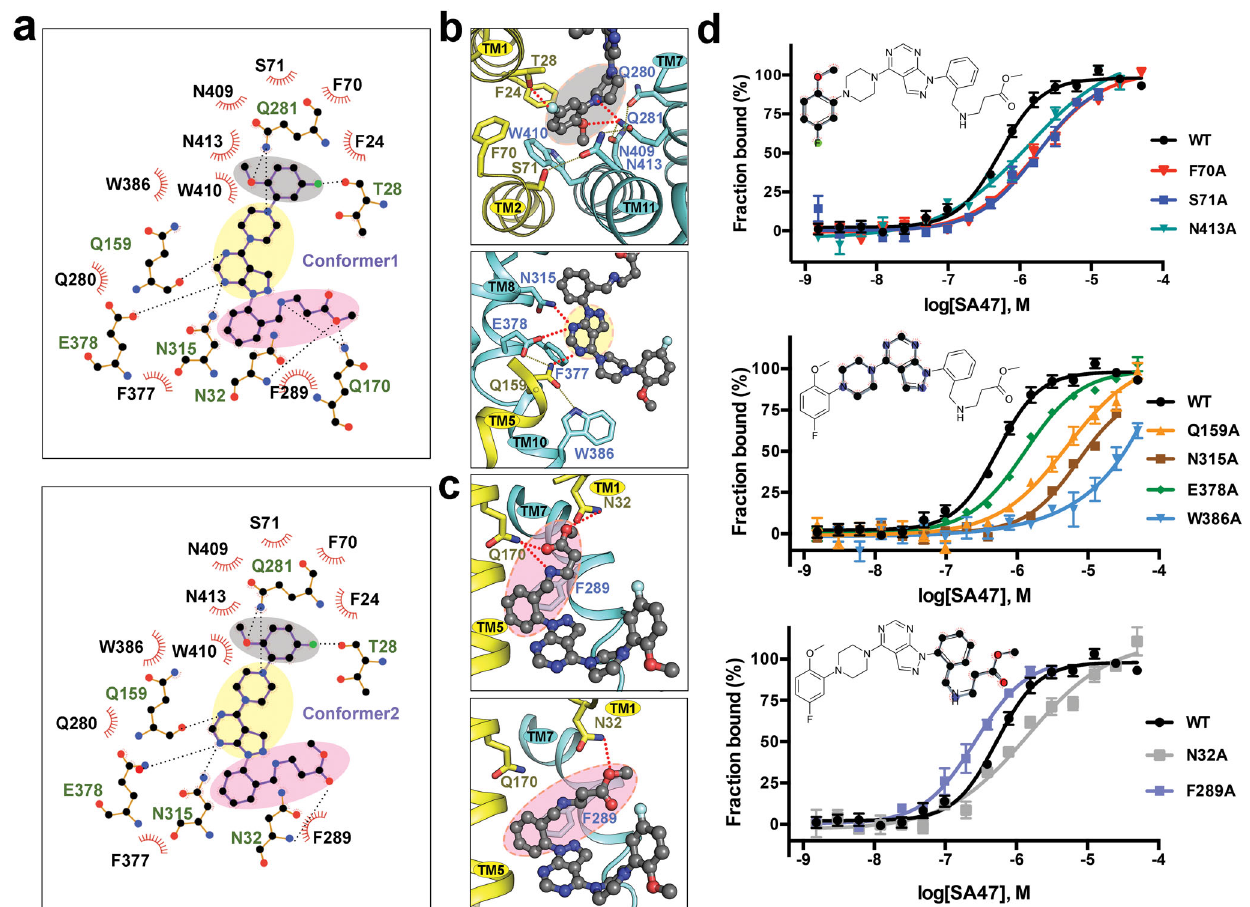
Fig. 4 Coordination of SA47 by GLUT3. a Schematic illustration of the interactions between GLUT3 and the two conformers of SA47. Schematics were generated in LIGPLOT + v.1.4.5. H-bonds are indicated by black, dashed lines. Hydrophobic contacts and π stacking interactions are represented by eyelash motifs. b Coordination of the fi rst three moieties of SA47. Top : coordination of the aryl head [1] (gray shade). Bottom : Coordination of the piperazine moiety [2] and the pyrazolopyrimidine core [3] (wheat shade). c Coordination of the two conformers of the pyrazoloaryl tail [4] (pink shade). Hydrogen bonds are indicated by red dashed lines. d Biochemical validation of the SA47 binding site. MST were performed to measure the interactions between SA47 and indicated GLUT3 variants. From top to bottom, GLUT3 mutants that were designed to impair the coordination of the aryl head [1] (top), the piperazine moiety [2] and the pyrazolopyrimidine core [3] (middle), and the pyrazoloaryl tail [4] (bottom) of SA47 were examined. Fractions bound of GLUT3 variants were normalized against that of wild-type GLUT3. Data represent mean ± SEM of three independent measurements. Please refer to Supplementary Table 2 for the summary of K D of the GLUT3 a similar protocol with minor modi fi cations 18 . In brief, the cDNA of human with D-glucoseat a fi nal concentrationof 50mMat4°Cfor30min. Thentheprotein GLUT3 was cloned into a modi fi ed pFastBac vector (Invitrogen) fused with an was mixed with monoolein (Sigma) with a protein to lipid ration (w/w) of N-terminal His 10 tag. All mutants were generated by standard PCR-based strategy. Following the instructions for the Bac-to-Bac baculovirus expression system (Invitrogen), proteins are overexpressed in the Sf9 insect cells with infected baculovirus after viral infection of 72 h. The protein was solubilized from Sf9 insect cell membrane with 2% (w/v) n-dodecyl- β -D-maltoside (DDM, Anatrace) at 4°C for 1.5h and puri fi ed using nickel af fi nity resin (Ni-NTA, Qiagen). The protein was washed with the buffer containing 25mM 2-(N-morpholino)ethanesulfonic acid (MES) pH 6.0, 150 mM NaCl, 30 mM imidazole, and 0.06% (w/v) 6-cyclohexyl-1- hexyl-b-D-maltoside (CYMAL-6, Anatrace) and eluted with the wash buffer plus 270 mM imidazole. Concentrated protein was applied to the size-exclusion chromatography (SEC) (Superdex-200, GE Healthcare) pre-equilibrated with the buffer containing 25 mM MES pH 6.0, 150 mM NaCl, and 0.06% (w/v) CYMAL-6. Peak fractions were collected and concentrated to approximately 40mg/ml using an Amicon Ultra 50 K fi lter (Millipore) for crystallization trials. Chemical synthesis . All screened and synthesized compounds were characterized for their inhibitory potential in a transporter assay using 2-desoxy-glucose (DOG) as a non-metabolizable substrate as described in the literature 31 . The origin and synthesis routes of the compounds are detailed in Supplementary Note 1. Crystallization . Both glucose-bound GLUT3exo and GLUT3-SA47 were crystallized programs from the CCP4 suite 43 . Phase was solved by molecular replacement using using LCP. For theGLUT3exo-glucose complex, concentrated GLUT3exo was mixed PHASER 44 with the structure of GLUT3 (PDB code: 4ZW9) as a searching model.